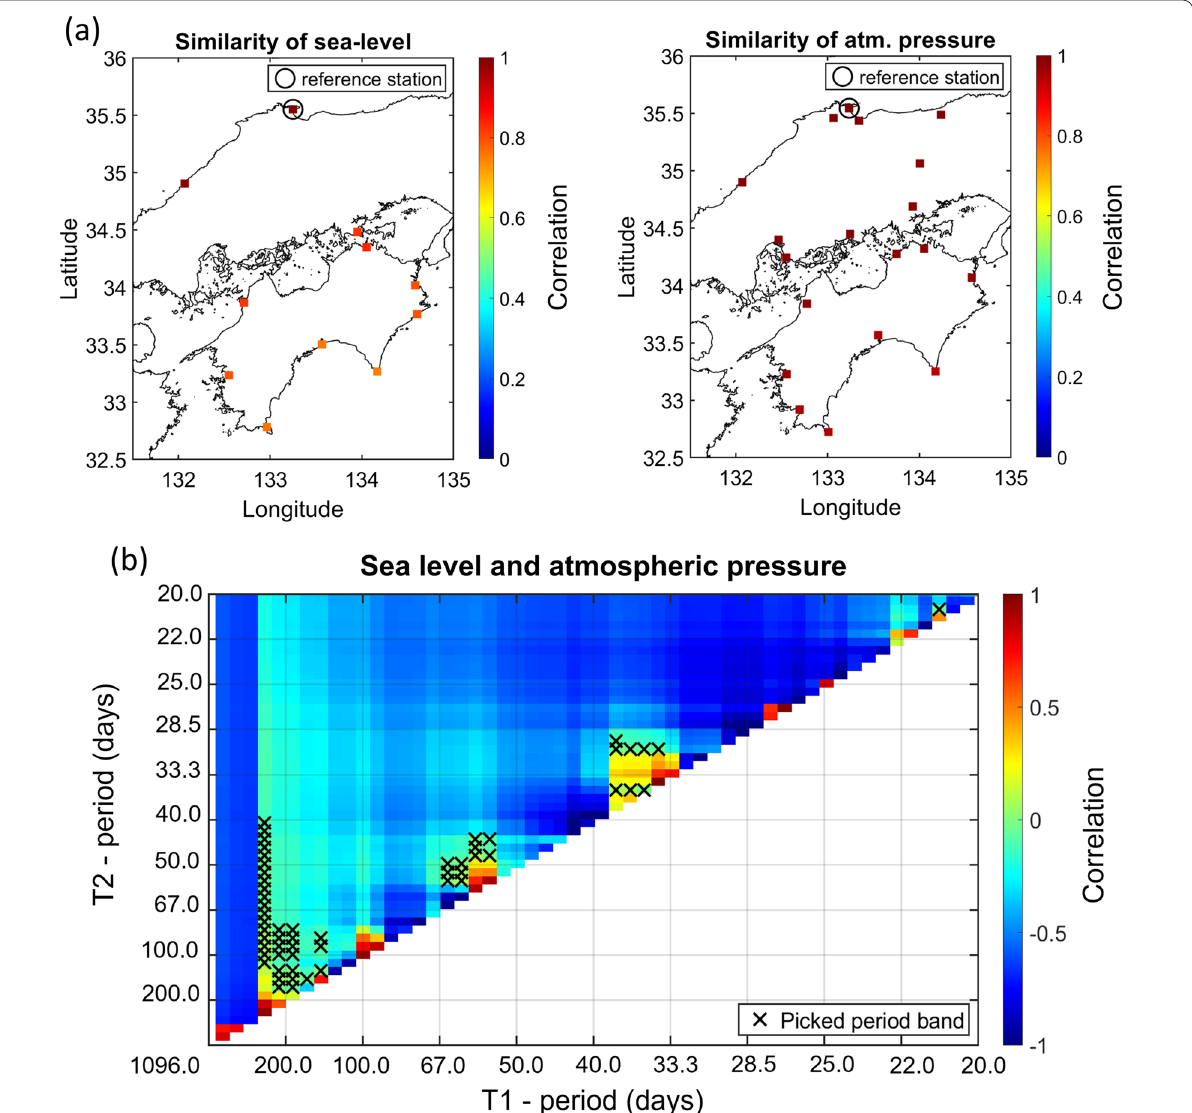
Fig. 3 a Maps of the study region showing the similarity of each station time series to that of the reference station for sea level (left panel) and atmospheric pressure (right panel). b Plot showing Pearson correlation coefficients between sea level and atmospheric pressure for various period bands (step 1). The black crosses indicate the range of period bands in which the value of the correlation coefficient between sea level and atmospheric pressure is less than 0.1. The period displays within 20–1096 period